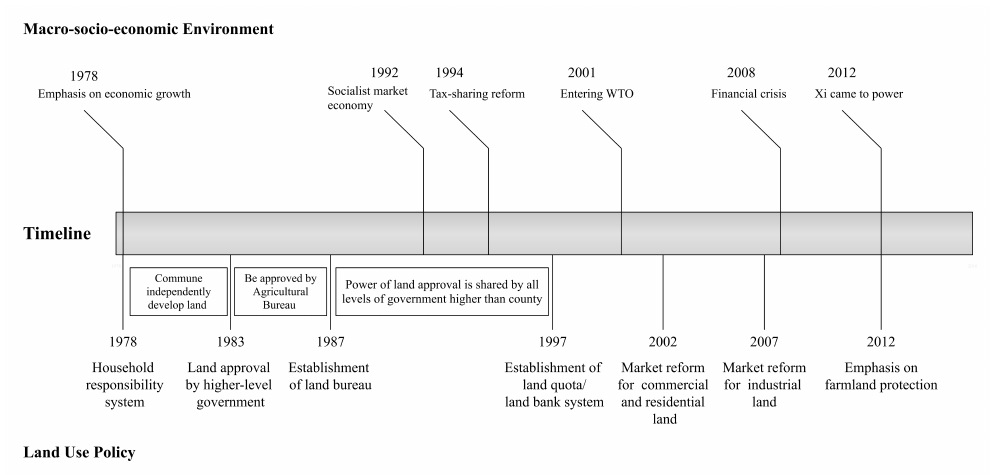
Figure 6. Some critical junctures of the central-local relation in land